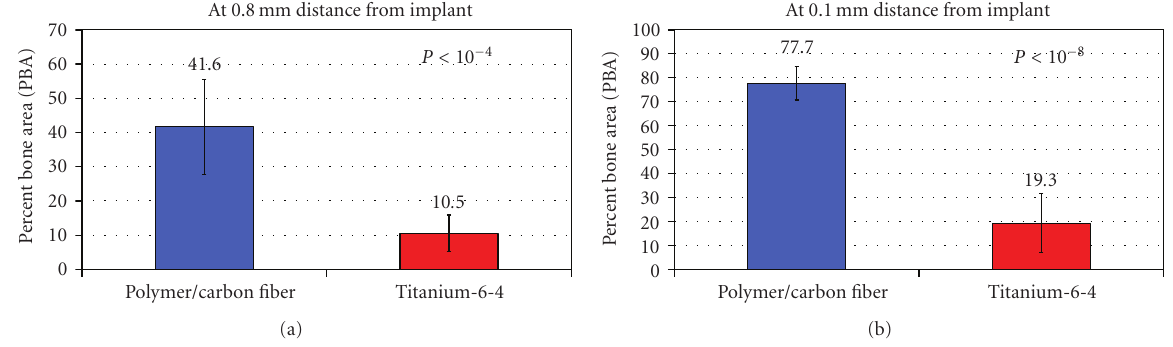
Figure 1: In vivo implant rat tibia PBA cross-sectional results at 0.8 mm and 0.1 mm from the implant surface at midcanal showing highly significant increases for the bisphenyl-polymer/carbon-fiber composite compared to titanium-6-4 alloy. (a) Comparisons for cross-sectional Group Mean PBA out to 0.8 mm from the implant, P < 10 − 4 . (b) Comparisons for cross-sectional Group Mean PBA out to 0.1 mm from the implant, P < 10 − 8 . The PBA was averaged from both distal and mesial implant surfaces separately at both 0.8 mm and 0.1mm. All data presented as the set average ± one standard deviation error bars. The sample size was 10 for all